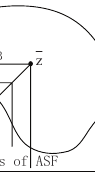
Fig. 3. Relationship between ASF and